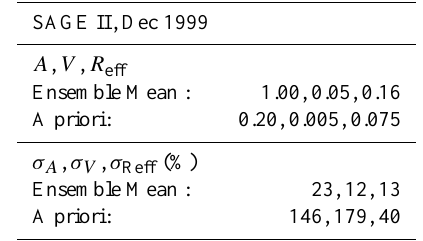
Table 6. Ensemble mean retrieved surface area density, volume density, and effective radius (SAGE II data, December 1999) with associated uncertainties (in %). Surface area density is given in µm 2 cm − 3 , volume density in µm 3 cm − 3 , and effective radius in